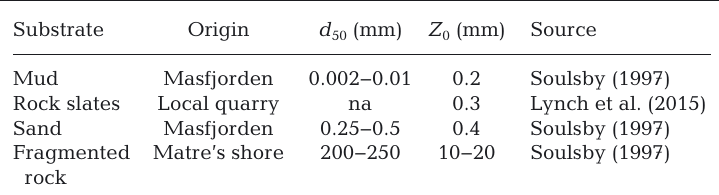
1. Substrate types used to represent most common bottom conditions in Norwegian aquaculture production zones. d 50 : median diameter, Z 0 : bed roughness length, na: data not